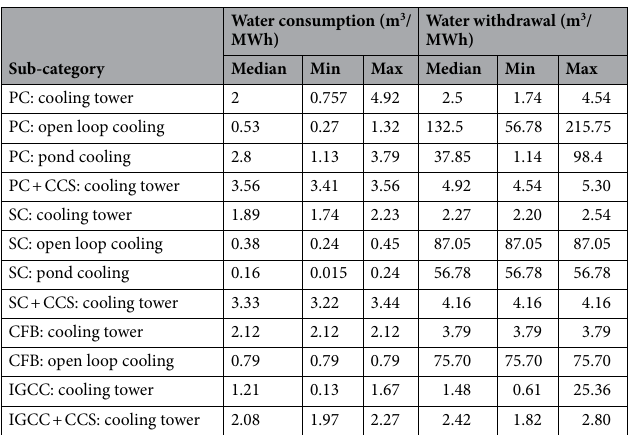
Table 9. Coal-fired power plant’s water withdrawal and consumption data 69 . PC = pulverized coal, sub- critical; SC = pulverized coal, super-critical; CFB = circulated fluidized bed; IGCC = integrated gasification combined cycle; CCS = carbon capture and sequestration.